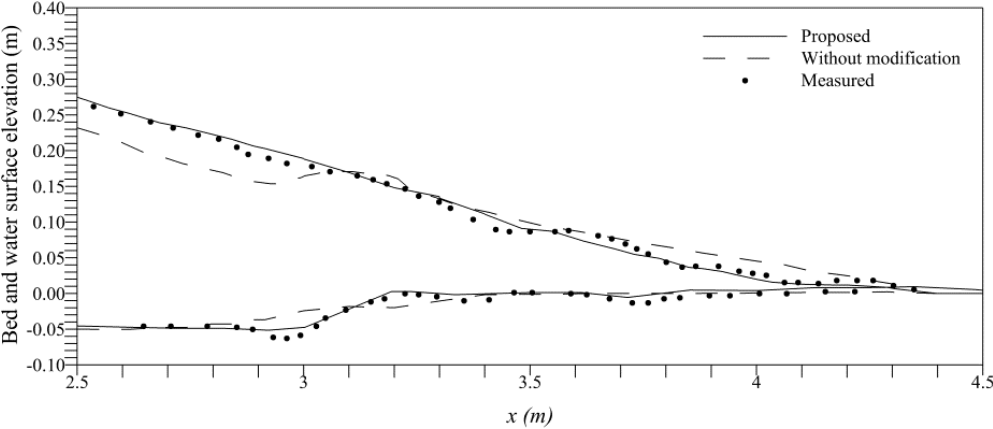
Figure 6. Numerical and experimental results of dam-break for configuration 2 at t = 0.5 s. Results for configuration 3 at t = 0.25 s, 0.75 s and 1.25 s after dam-break are presented in Figure 7.